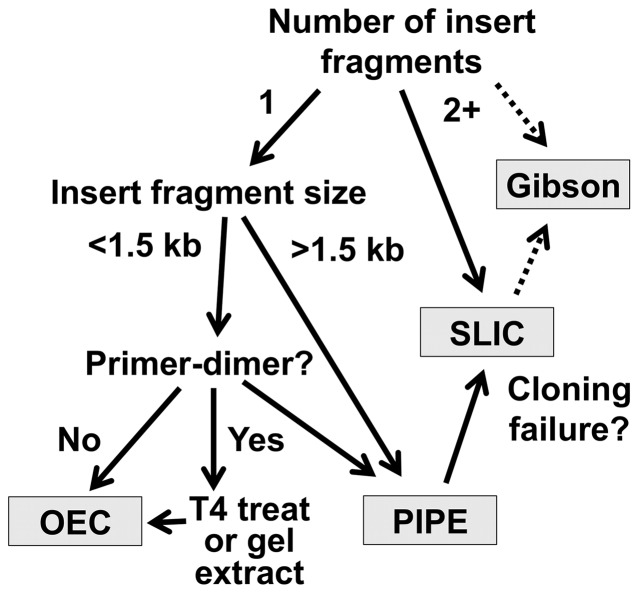
Technique selection flowchart for a new cloning project.The number of fragments, their size, primer availability and the presence of primer-dimers will determine the optimal cloning strategy. See main text for details.